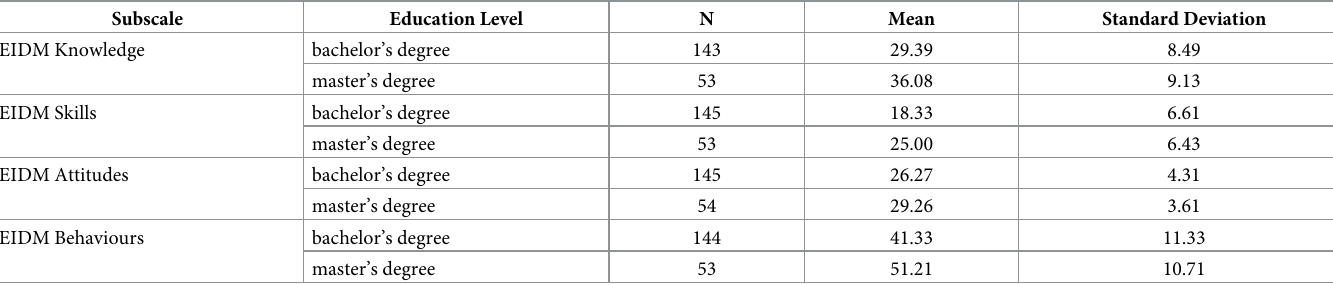
Table 8. Mean EIDM competence scores based on education.